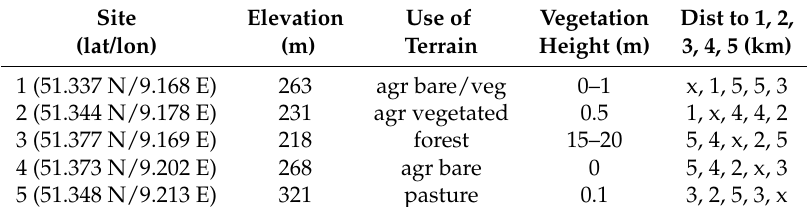
Table 1. Physical characteristics of the sounding locations.